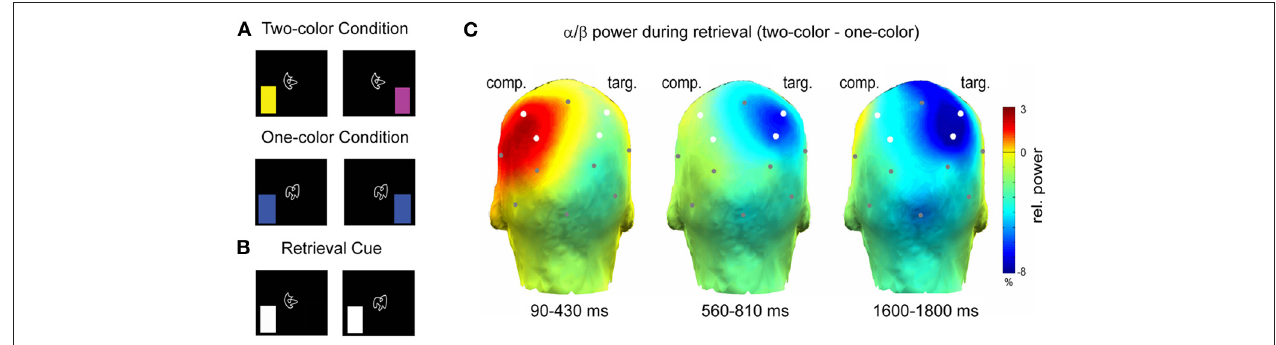
FIGURE 5 | Alpha/beta power during selective retrieval. (A) Subjects encoded shape—color pairs. In one condition two colors were associated with a shape, in the other condition one color was associated with a shape. (B) During the selective retrieval phase the shape was presented together with a cue, specifying the to-be-retrieved target color. (C) Alpha/beta power